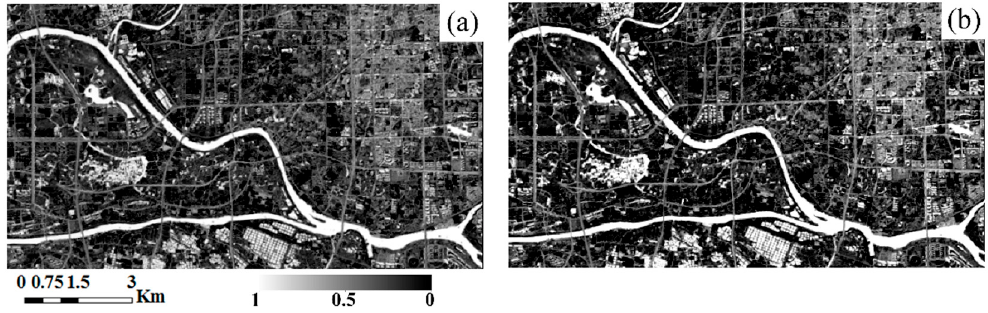
linear spectral mixture analysis (LSMA) methods.